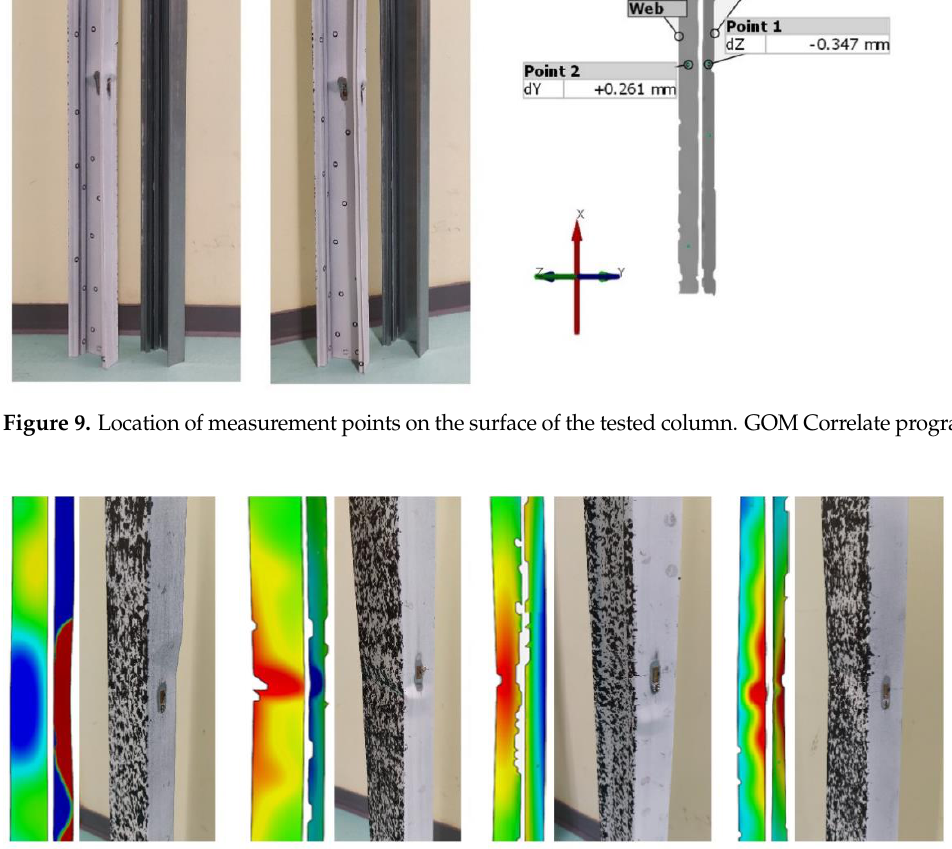
Table 6. Displacement values for flange and web measurement points obtained using the optical method.